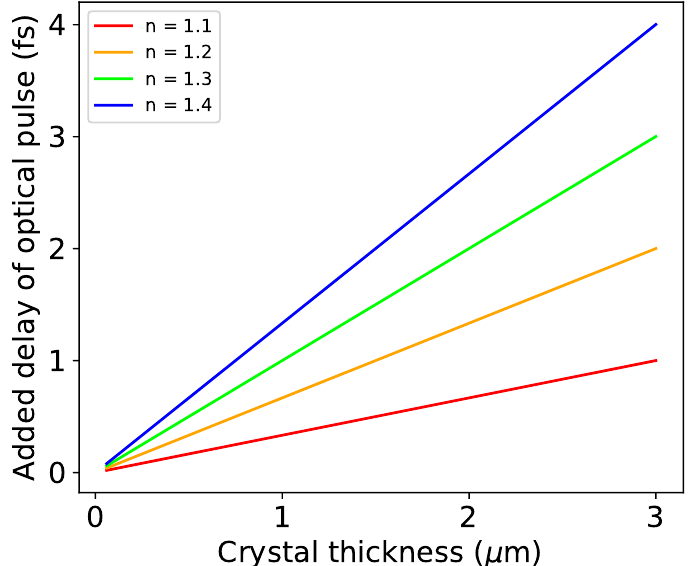
Figure 10. Group velocity mismatch. Added delay of the optical pump pulse compared to the X-ray probe due to group velocity mismatch when propagating through a protein crystal. The effect is plotted as a function of crystal thickness and for different possible refractive indexes of protein